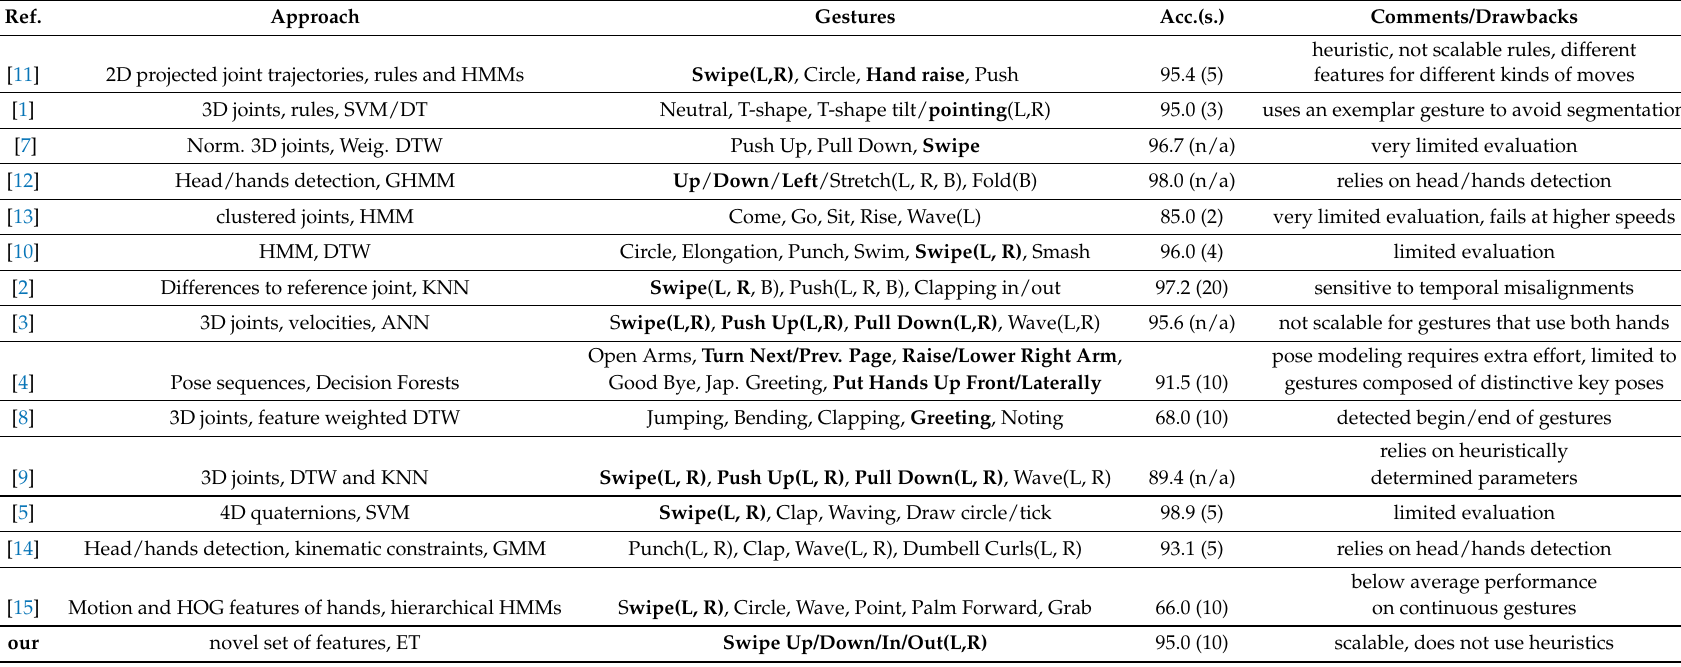
Table 9. Reported results of the state-of-the-art (alphabetically). The 2nd column (Approach) summarizes features and learning approach used. In the 3rd column (Gestures), relevant gestures to those of our work are in bold. The 4th column (Acc.(s.)) presents the best accuracy achieved in the used dataset and the number of subjects in